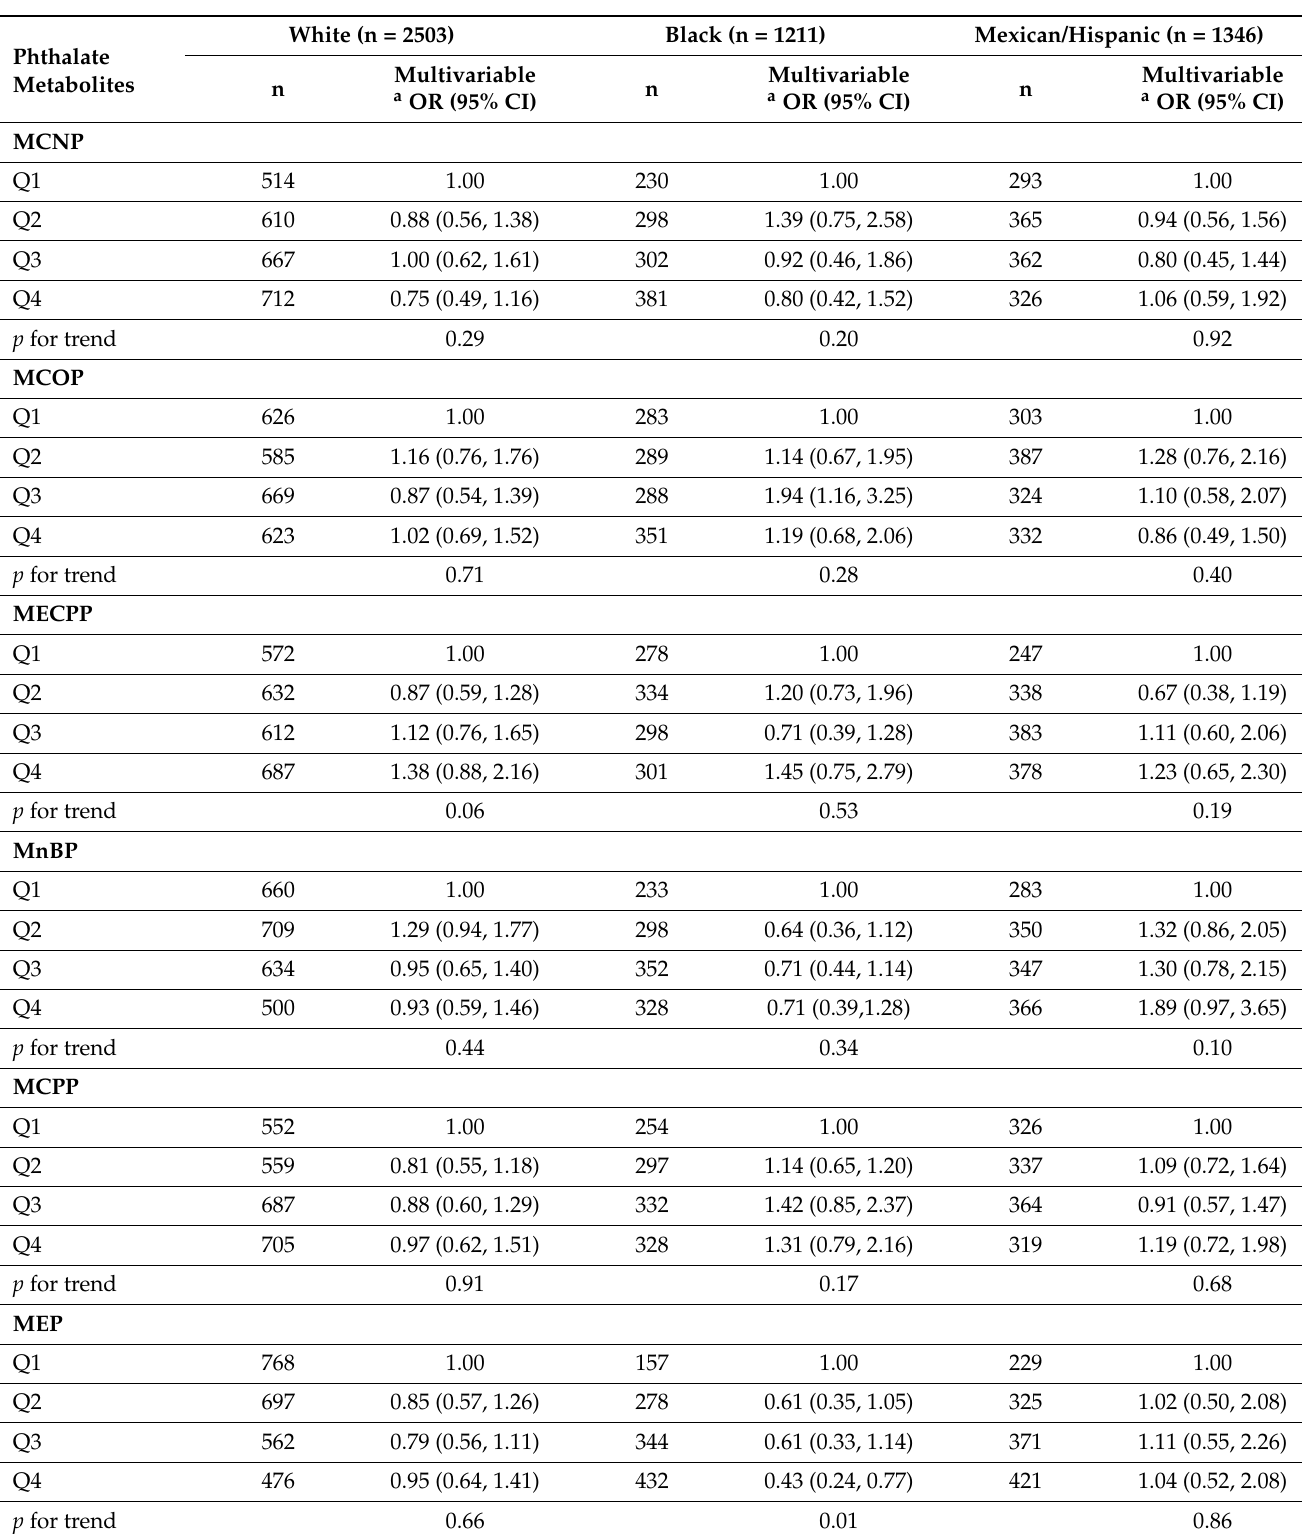
Table 4. Associations between urinary phthalate metabolite concentrations and metabolic syndrome among men by race, NHANES